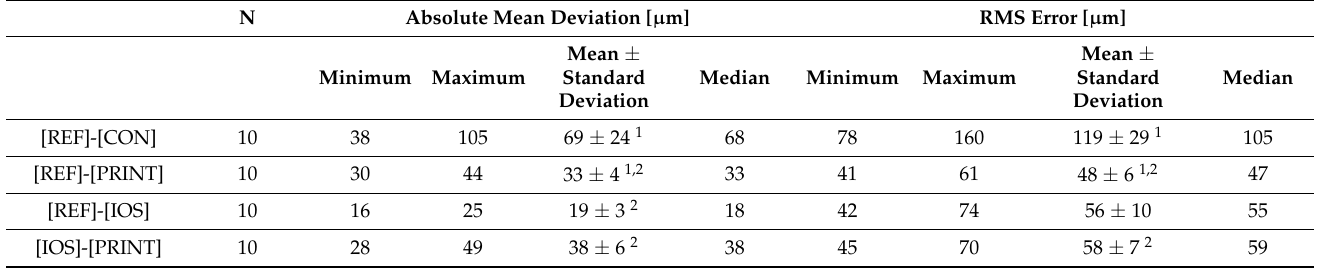
Table 2. Full-arch trueness